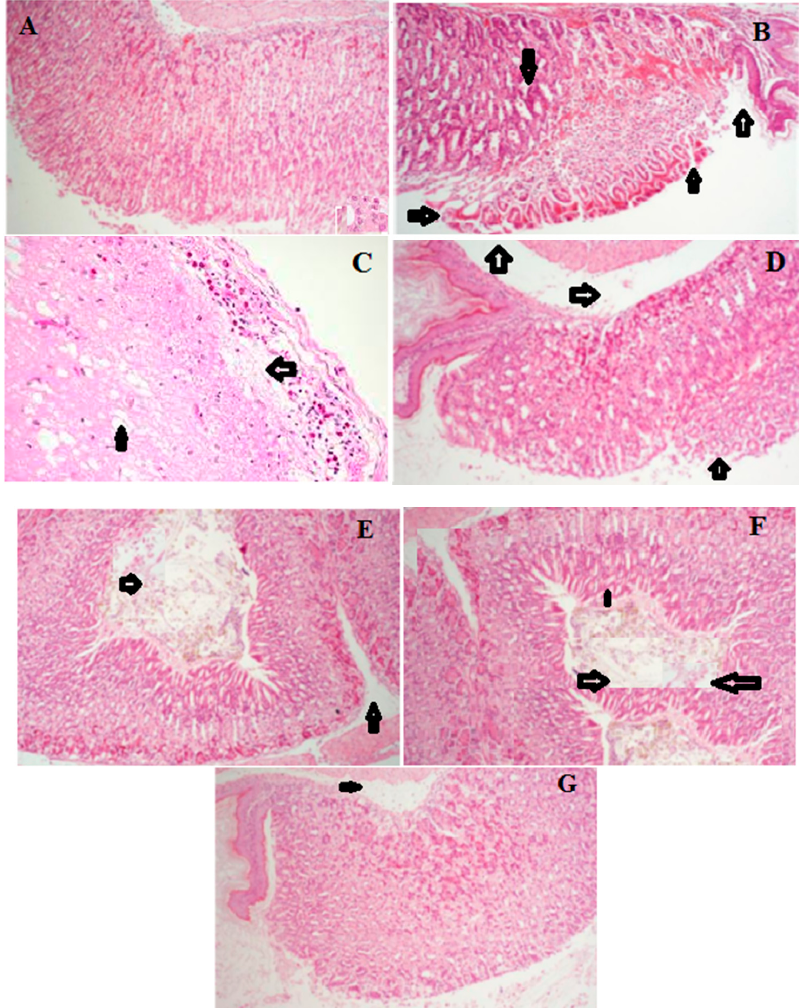
Figure 5. Effects of LCA on cytokine levels in the serum. Data are expressed as the mean ± SD ( n = 8). ##: p < 0.01 vs. control group. **: p < 0.01 vs. model group. (CON = control; OME = omeprazole). 2.6. Histology of Gastric Lesions